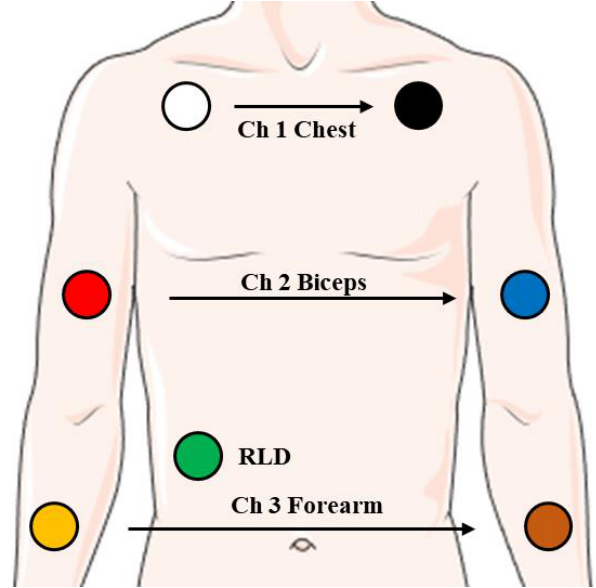
Figure 2. The electrode placement position in the experiment. In Experiment 2, the signal is only collected from channel 1. Table 1. Summary of demographic information of subjects that participated in experiments.